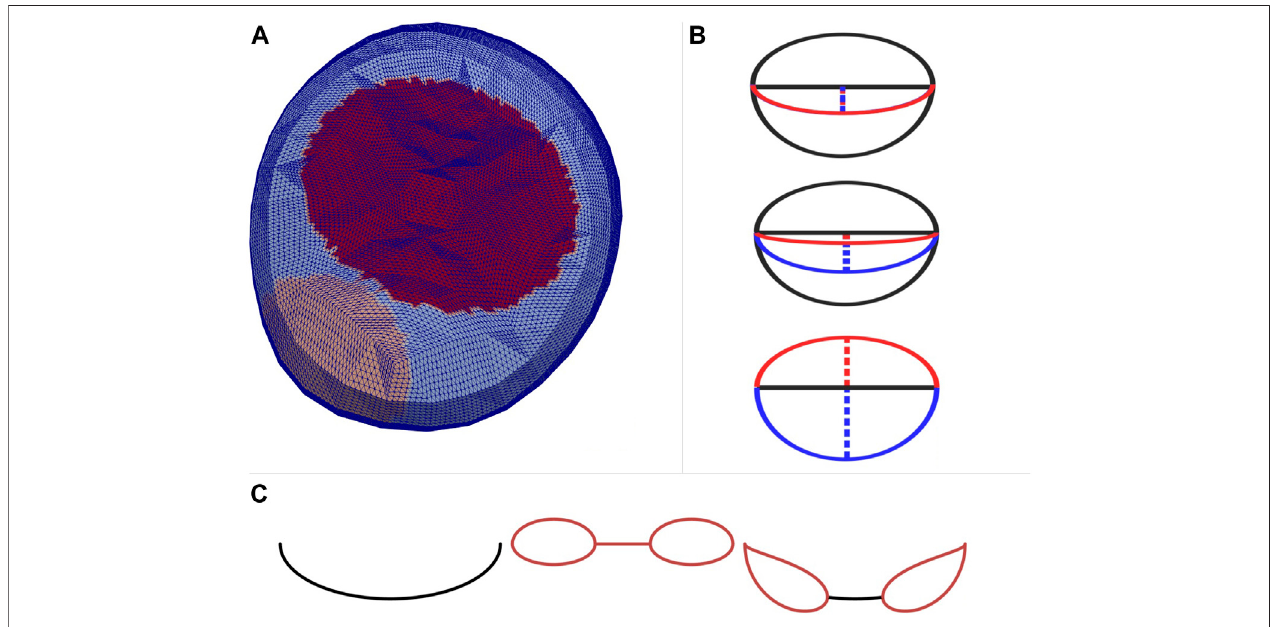
FIGURE 1 | (A) AV placement (tan) and MV placement (red) on the LV surface mesh in an axial view. (B) The two half ellipses making up the MV model at different stagesthroughouttheheartbeatcycle.Thesolidredlineistheprojectionoftheanteriorlea fl et,andthesolidbluelinetheposterior. Thedashedlinesaretheshortaxesof the corresponding half ellipse. In the top view the valve is fully closed (systole), and the lea fl ets overlap on the coaptation line. In the bottom view the valve is fully open (E-wavepeak),andthecenterviewshowsearlydiastole.Thesolidblacklinethroughthevalvemodelisthelongaxesofthetwohalfellipses. (C) Thecoaptationline (left), thetwodoublehalfellipsesmaking uptheMVmodelafter MVCintervention(center) and the fi nalshapeoftheMVmodel afterMVCintervention (right).Thepartthat does not open is the location of the clip.